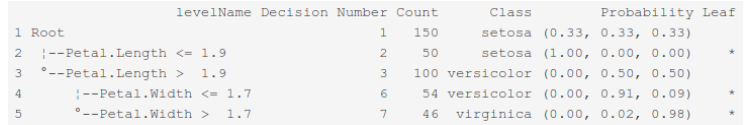
Figure 7. Final tree structure using fully automated learning for the Iris data set.